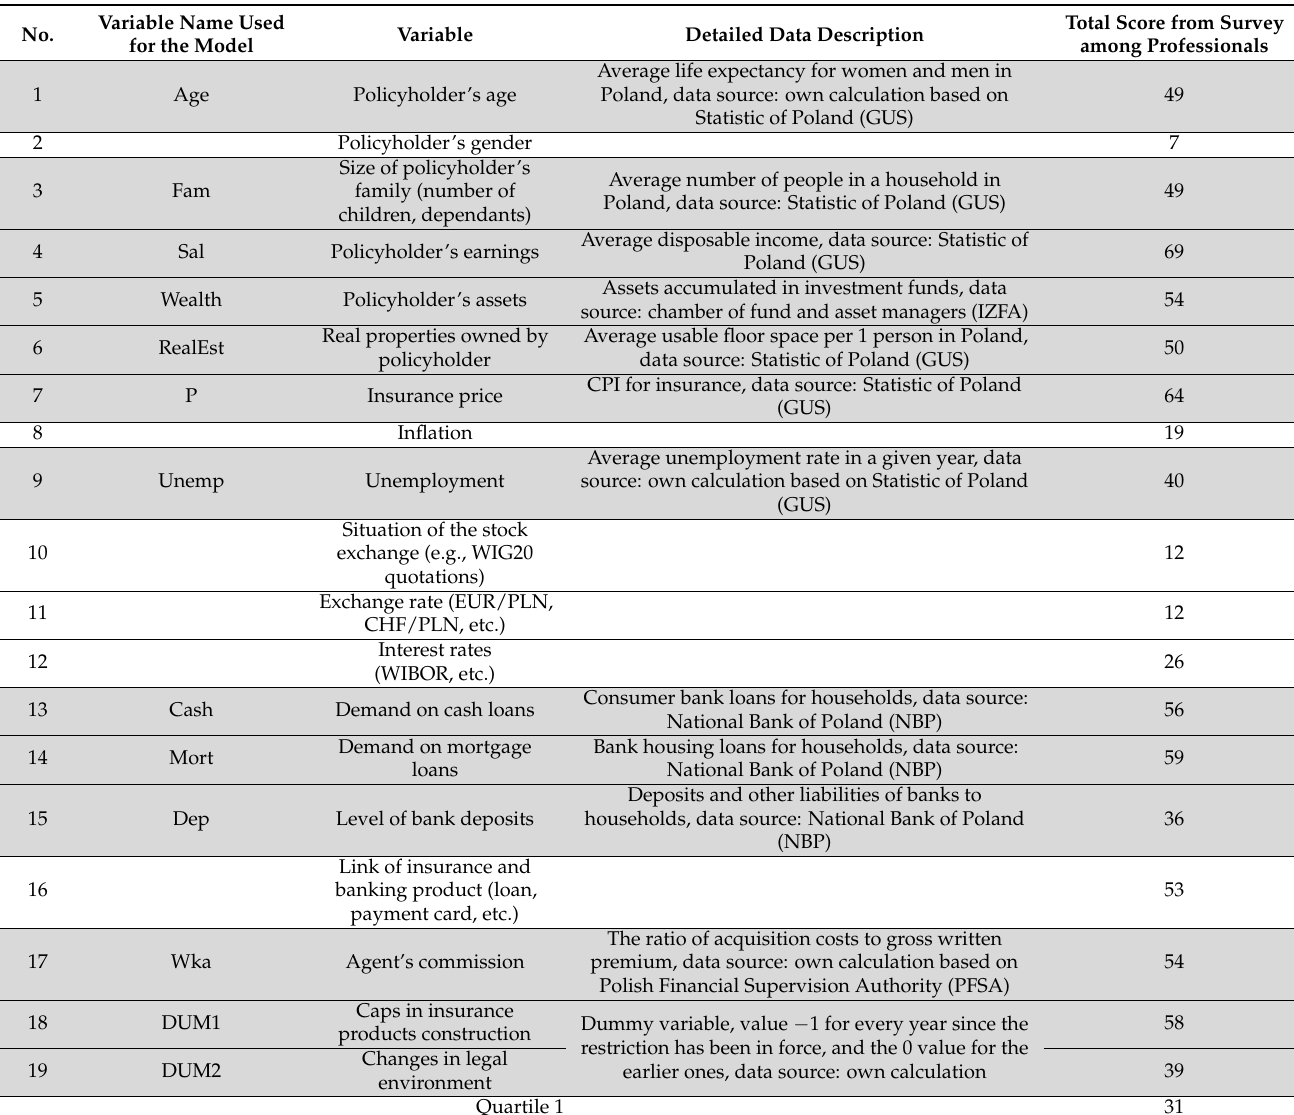
Table 4. Results of a survey among financial institution